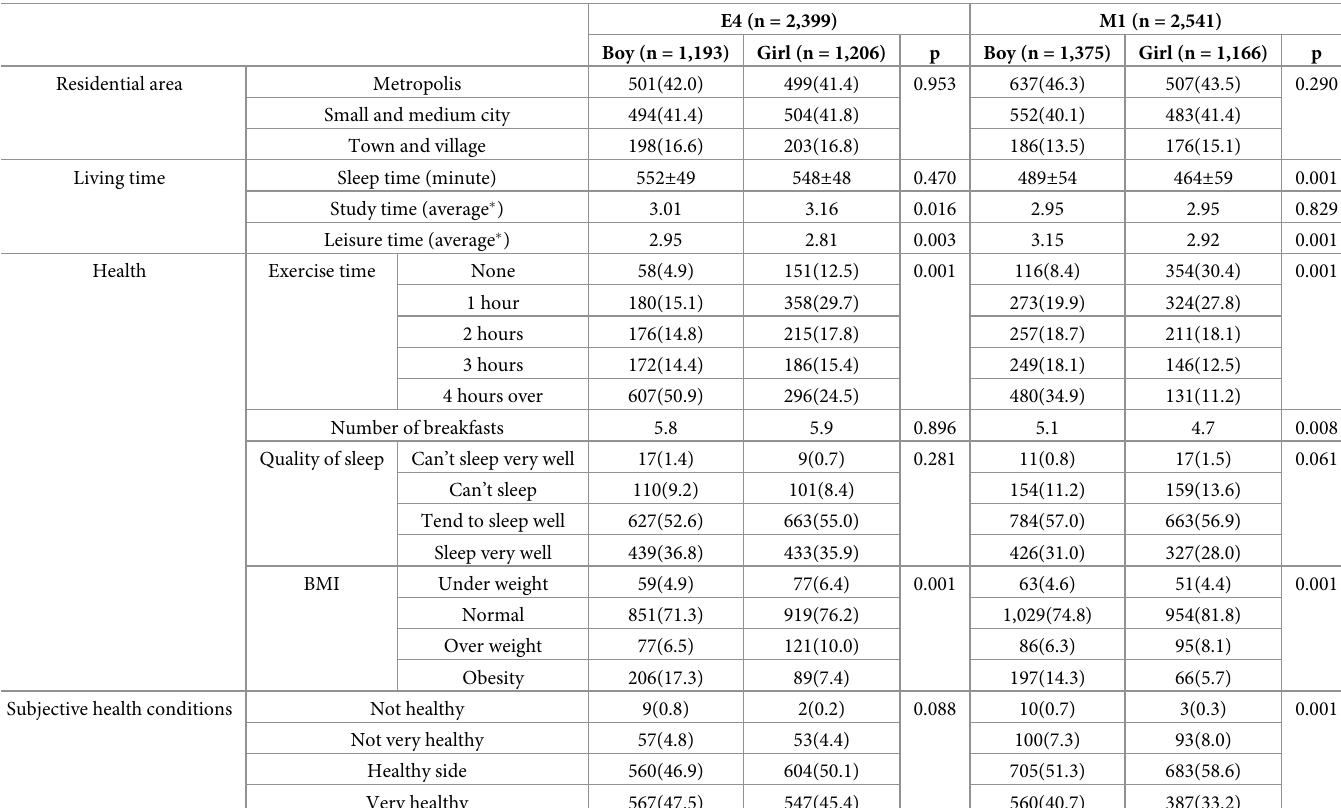
Table 1. Demographic characteristics (N =